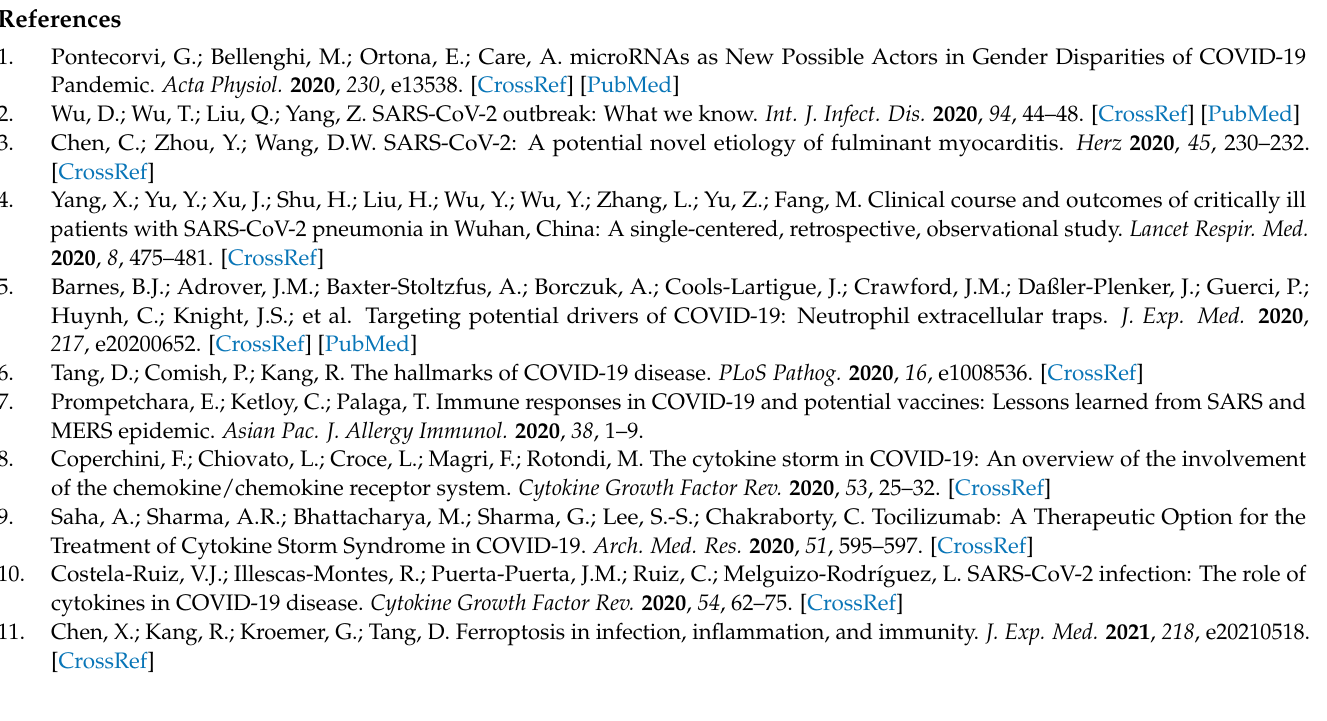
Table S3: Univariate and multivariate logistic regression analysis for the parameters affecting compli- cations, Table S4: Univariate and multivariate logistic regression analysis for the parameters affecting mechanical